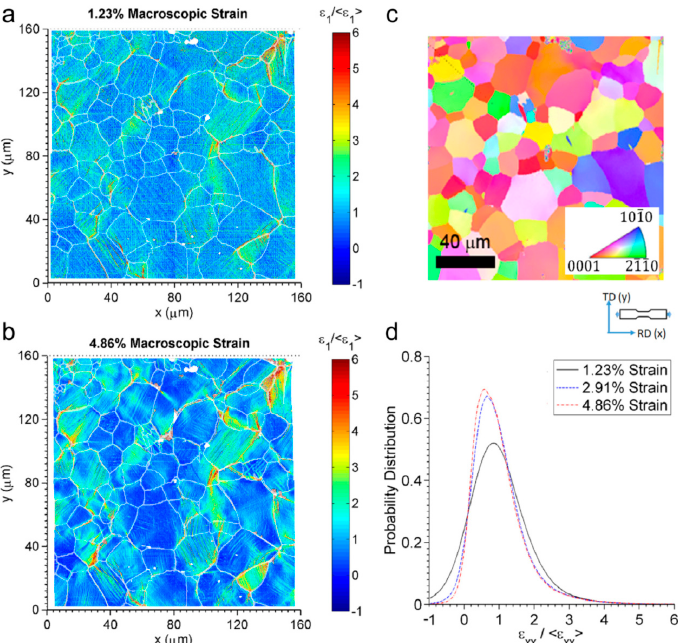
Figure 17. Using SEM-DIC technique to investigate the underlying deformation mechanisms in WE43-T5 Mg alloy during tensile loading along the rolling direction: ( a ) The map of normalized maximum principal strain maps at ε = 1.23%, ( b ) the map of normalized maximum principal strain maps at 𝜀 (cid:3404) 4.86%, ( c ) the inverse pole figure map, ( d ) a probability distribution of the strain